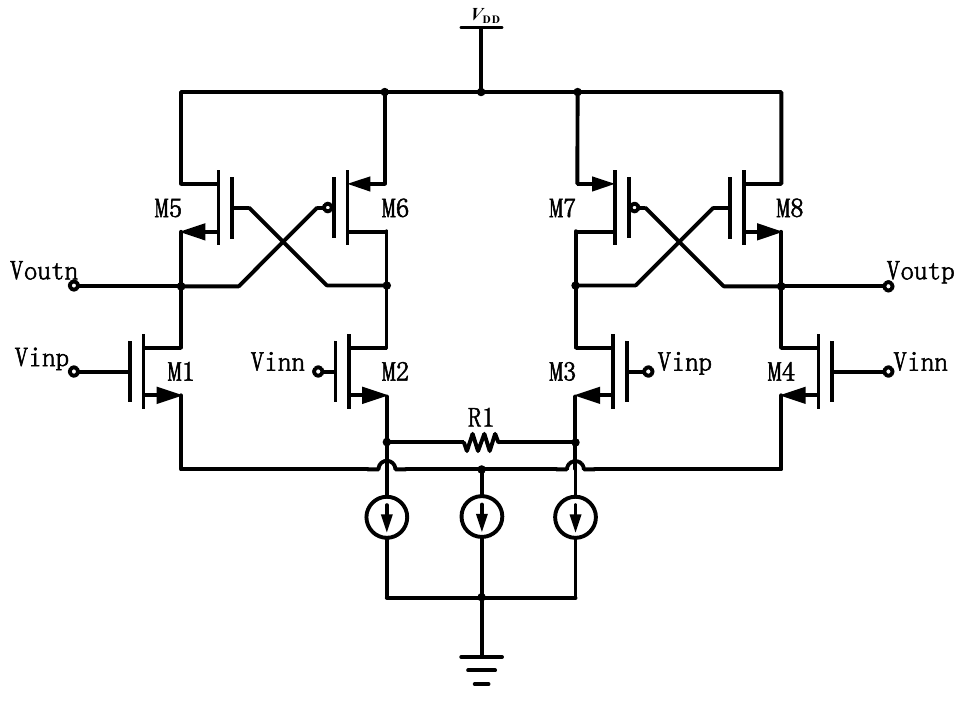
Figure 12. Buffer schematic. Figure 12. Bu ff er schematic. Table 9. Component sizes and simulated performance Table 9. Component sizes and simulated performance specifications.